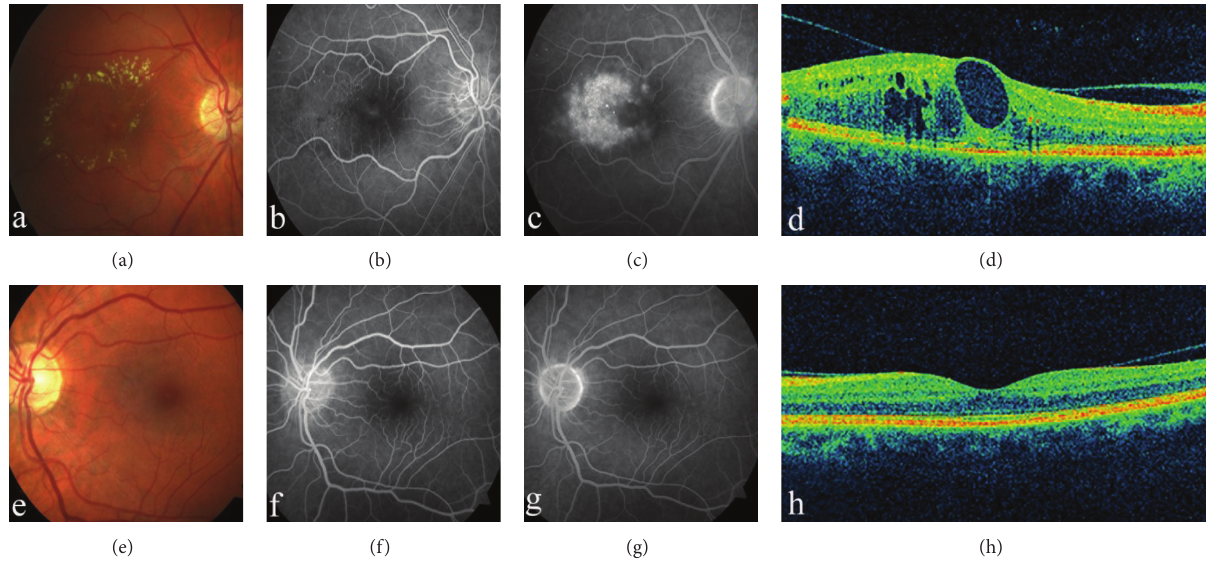
Figure 1: Before Treatment . Fundus photograph ((a) right eye, (e) left eye), early phase ((b) right eye, (f) left eye), late phase fluorescein angiography ((c) right eye, (g) left eye), and macular OCT ((d) right eye, (h) left